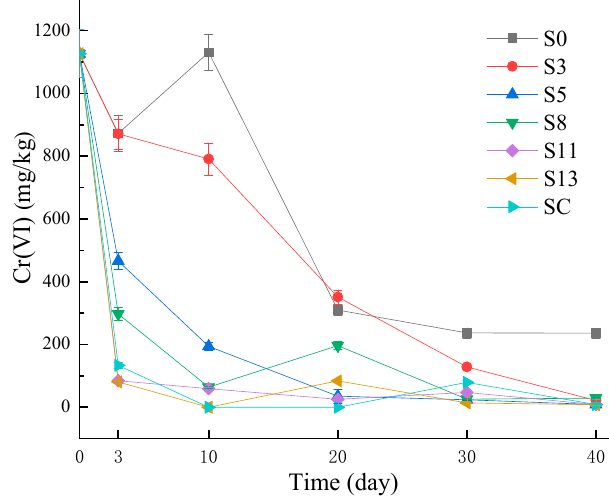
Figure 1. Changes in Cr(VI) concentration during remediation.